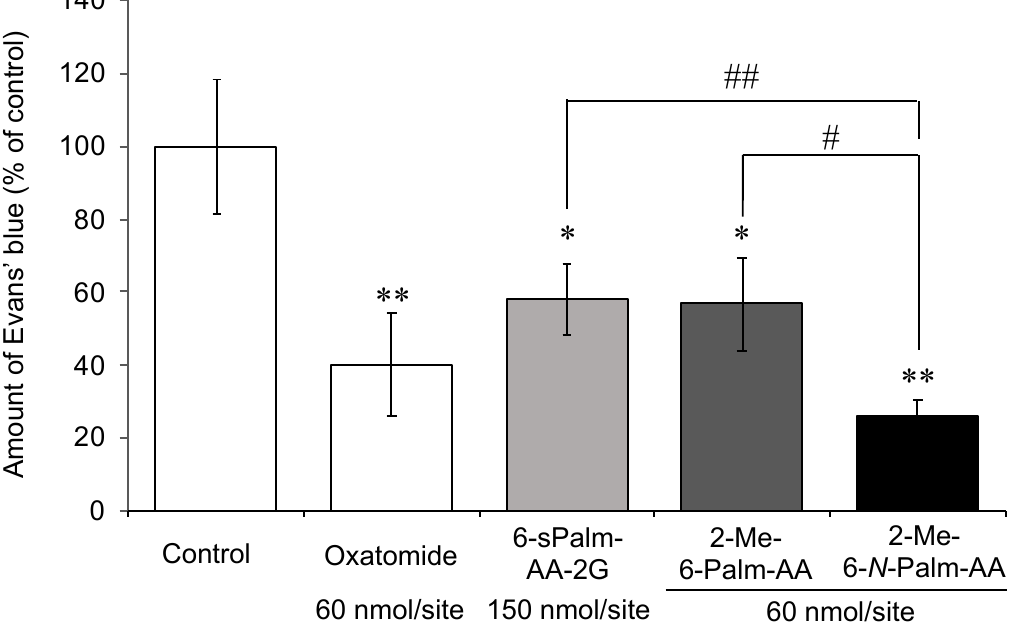
Figure 7. Inhibitory effect of 2-Me-6- N -Palm-AA on the antigen-stimulated PCA reaction in mice. Mice were percutaneously administered the indicated samples: control ( n = 9), oxatomide ( n = 9), 6-sPalm-AA-2G ( n = 9), 2-Me-6-Palm-AA ( n = 7), and 2-Me-6- N -Palm-AA ( n = 8). All data represent the means ± SE. * p < 0.05 and ** p < 0.01 (Dunnett’s test) as compared with the control. # p < 0.05 and ## p < 0.01 ( t -test).